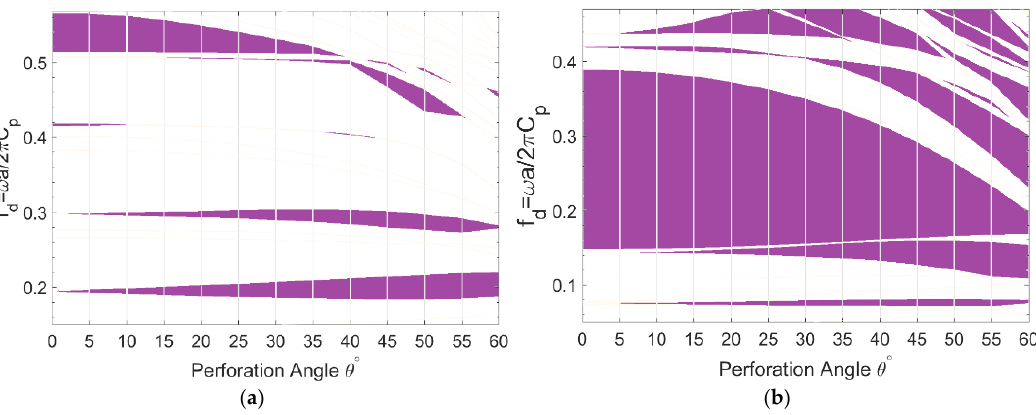
Figure 4. Variation of frequency ranges corresponding to the bandgaps of mixed guided wave modes opened within the first 10 modal branches versus perforation angle 0 ◦ ≤ θ ≤ 60 ◦ , ( a ) partial bandgap of prescribed topology PT2 and ( b ) partial bandgap of optimized topology CT1 in ΓΧ .